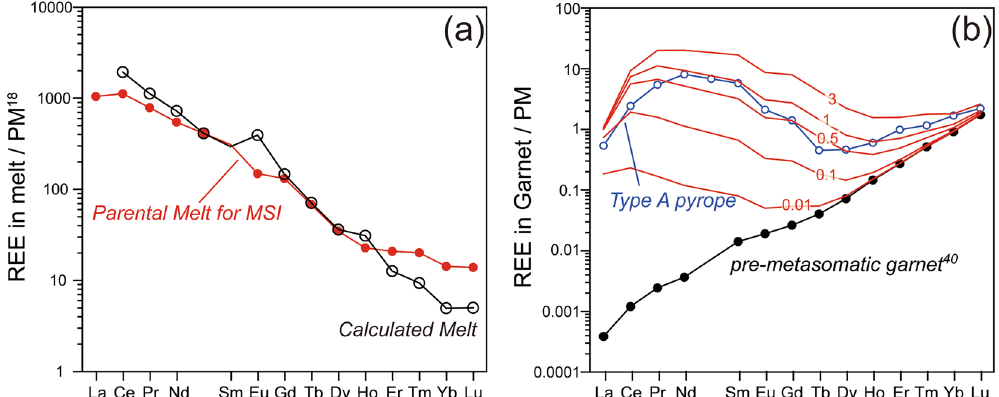
Figure 7. Panel (a) shows a calculated REE pattern of a carbonated melt in equilibrium with the core of an orthopyroxene porphyroclast, normalized to primitive mantle (PM) values 18 . The calculated REE pattern of the melt agrees well with that of the reconstructed REE pattern for the MSIs. Panel (b) shows a result of REE modelling of a reaction between pre-metasomatic garnet 40 and a calculated carbonatite melt. The red-coloured curves are calculated patterns for varying volumes of carbonatite melt that reacted with garnet. Garnet–melt partition coefficients are after ref. 39 . Only 0.5–1.0% carbonatite melt relative to garnet is needed to generate the observed sinuous REE pattern in Type A